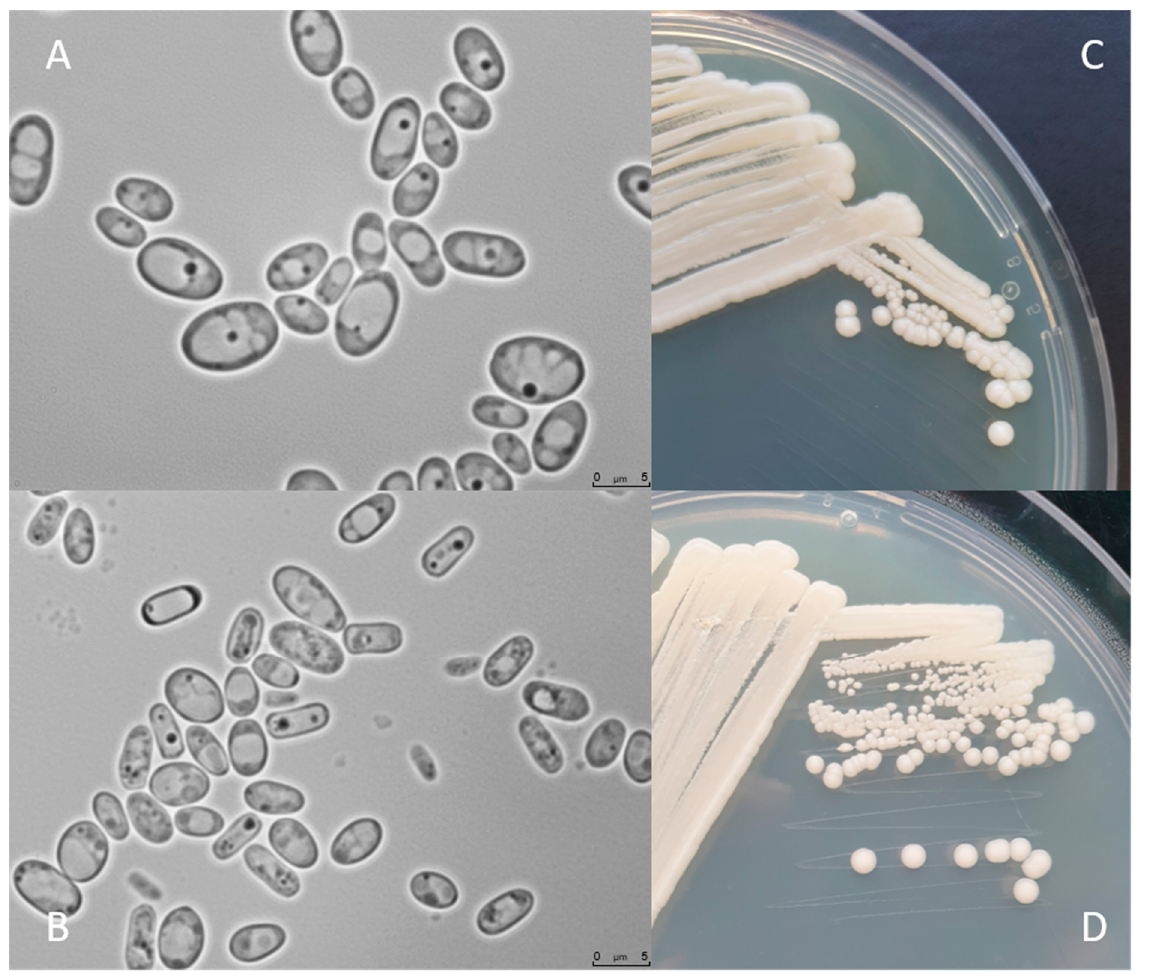
Figure 2. C. jadinii DSM 2361 morphological traits. ( A ) Microscopic photographs of C. jadinii cells after 3 days ( A ) and 12 days ( B ) of growth at 30 ◦ C on yeast extract-peptone-dextrose media. Scale bars are 5.0 µ m. Macro-morphological features of C. jadinii after 3 days of growth in YPD ( C ) and Malt Extract Agar ( D ) media, at 30 ◦